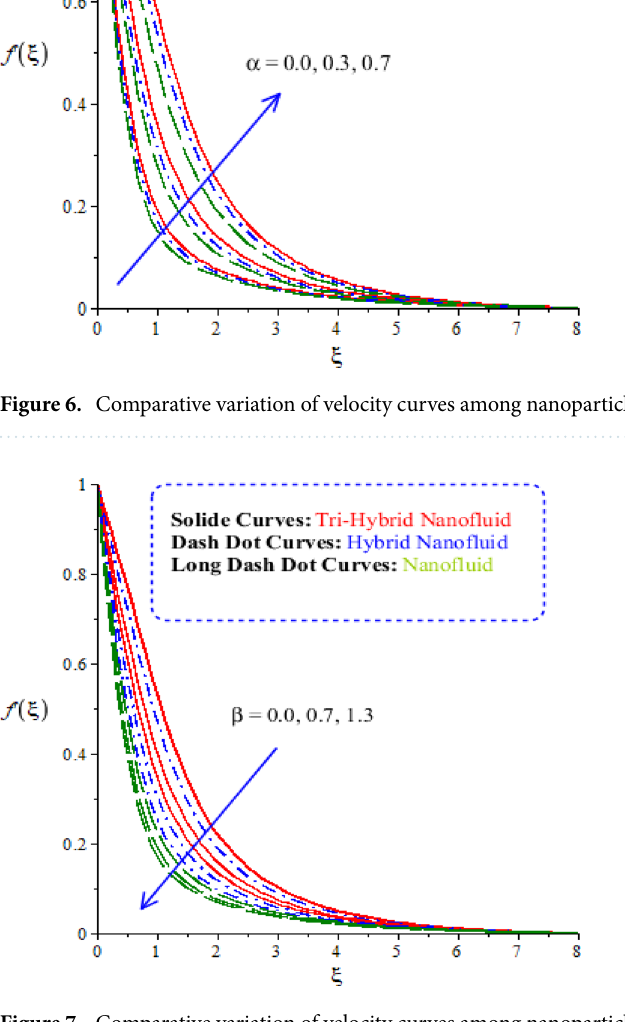
Figure 7. Comparative variation of velocity curves among nanoparticles versus β